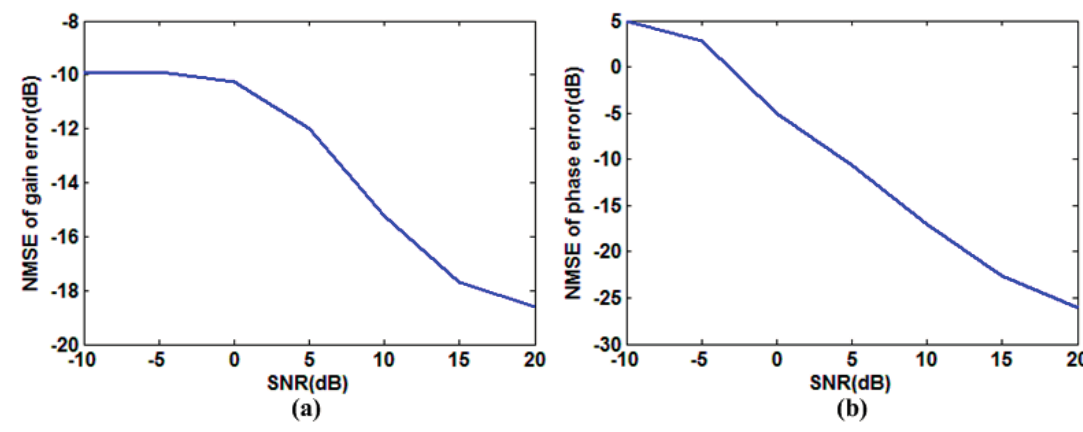
Figure 4. RIE versus SNR.